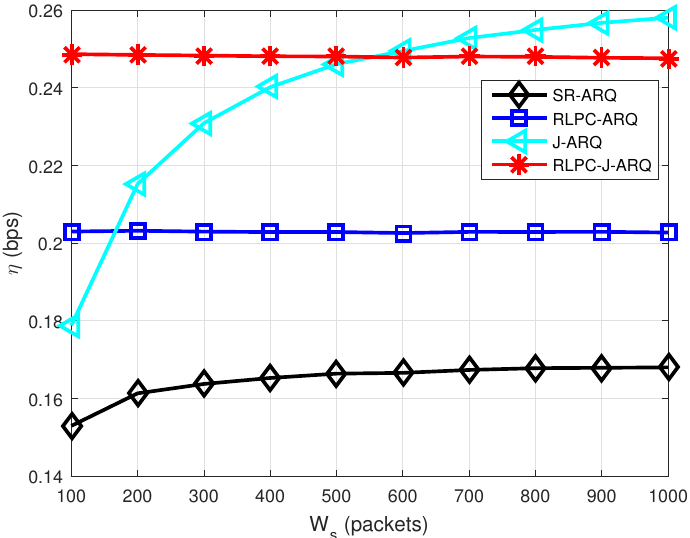
Figure 3. Throughput efficiency as a function of the number of source data W s